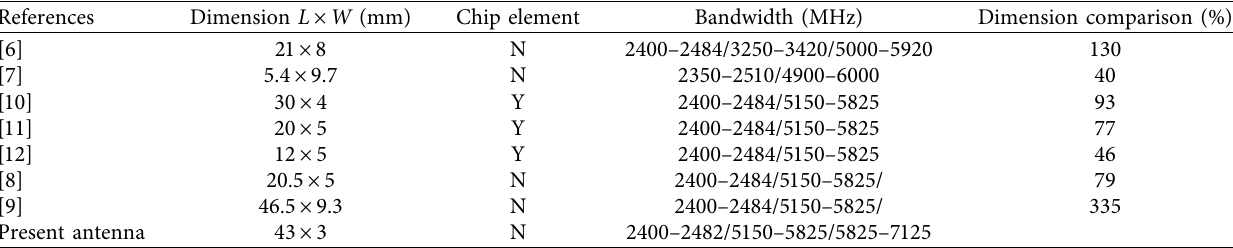
Table 4: Comparison of proposed antenna with other